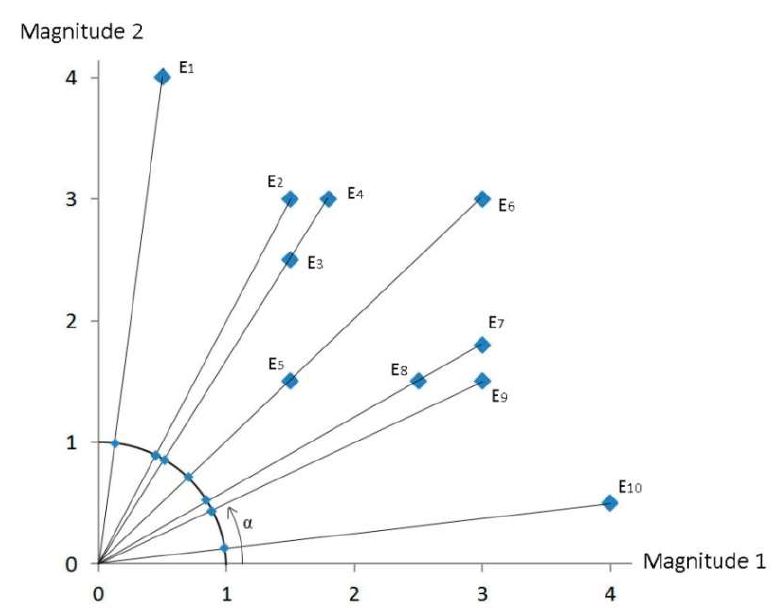
Figure 2. Angles ( α ) of the ten firms (E 1 to E 10 Figure 2. Angles (α) of the ten firms (E 1 to E 10 ). Figure 2. Angles (α) of the ten firms (E 1 to E 10 ).